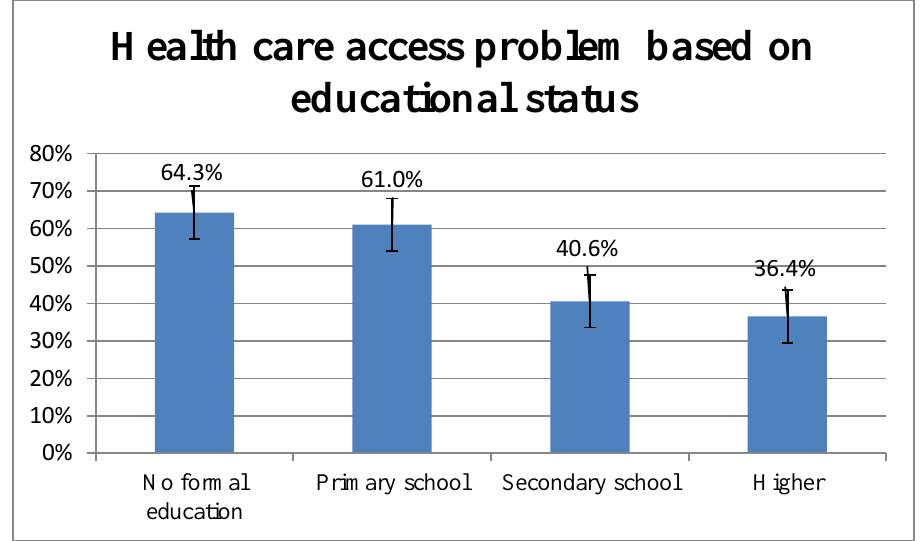
Figure 2. Magnitude of healthcare access problem among women of reproductive age (15–49) in Benin, based on educational status: evidence from 2018/2019 Benin DHS.